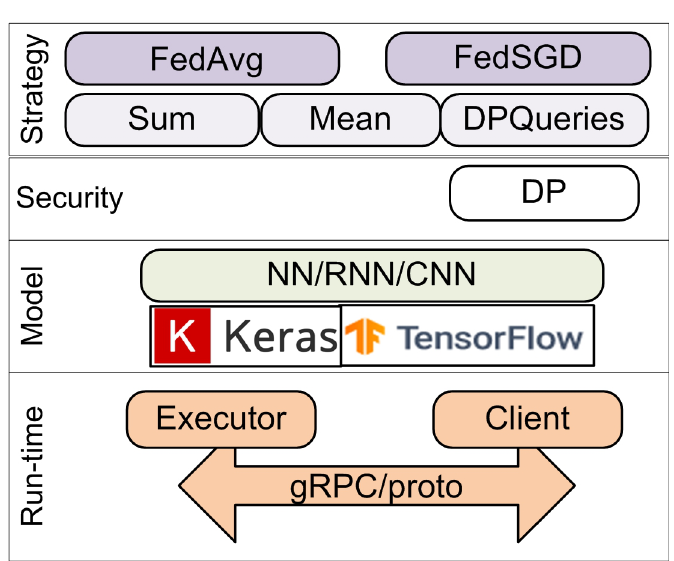
Figure 4. Architecture of TensorFlow Federated